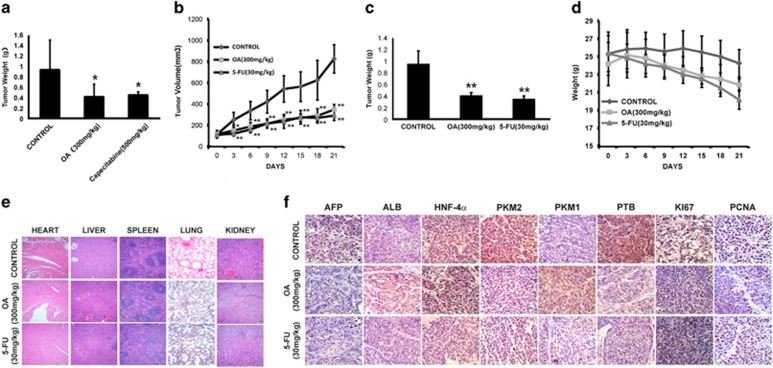
OA inhibited the tumor growth of hepatoma xenograft in vivo. (a) NOD-SCID mice with xenografts of HepG2 cells were used to study the anti-hepatoma activity of OA in vivo. The NOD-SCID mice were treated with saline control, OA (300 mg/kg, ig.) and capecitabine (500 mg/kg, i.g.). Tumor masses were showed. (b–f) PDTX model mice with patient derived tumor were treated with saline control, OA (300 mg/kg, i.g.) and 5-FU (30 mg/kg, intravenous). Changes of tumor volumes (b), tumor weight (c) and animal weights (d) were shown. (e) Hearts, livers, spleen, lungs and kidneys were retrieved and sectioned for HE staining (magnification, × 200). (f) Immunohistochemistry analysis of AFP, ALB, PTB, PKM1, PKM2, HNF-4α, KI67 and PCNA (magnification, × 400). Bars, SD. *P<0.05 or **P<0.01 versus control group